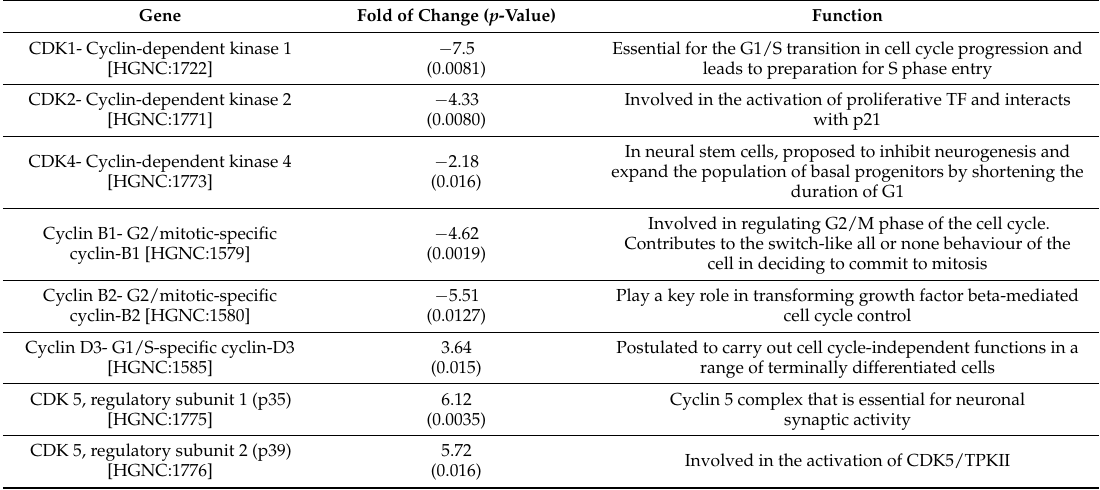
− 7.5 Essential for the G1/S transition in cell cycle progression and (0.0081) leads to preparation for S phase entry − 4.33 Involved in the activation of proliferative TF and interacts (0.0080) with p21 In neural stem cells, proposed to inhibit neurogenesis and − 2.18 expand the population of basal progenitors by shortening the (0.016) duration of G1 Involved in regulating G2/M phase of the cell cycle. − 4.62 Contributes to the switch-like all or none behaviour of the (0.0019) cell in deciding to commit to mitosis − 5.51 Play a key role in transforming growth factor beta-mediated (0.0127) cell cycle control 3.64 Postulated to carry out cell cycle-independent functions in a (0.015) range of terminally differentiated cells 6.12 (0.0035) 5.72